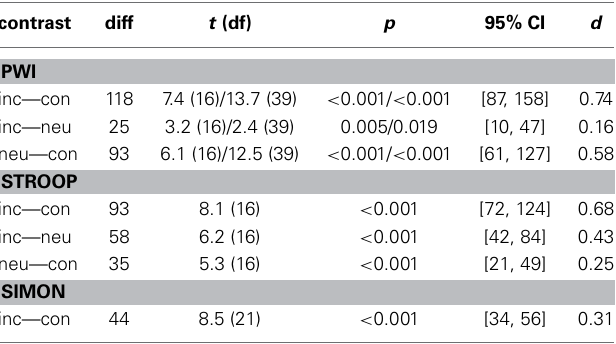
Table 4 | Results of the pair-wise comparisons of response times between conditions for the picture-word interference, Stroop, and Simon